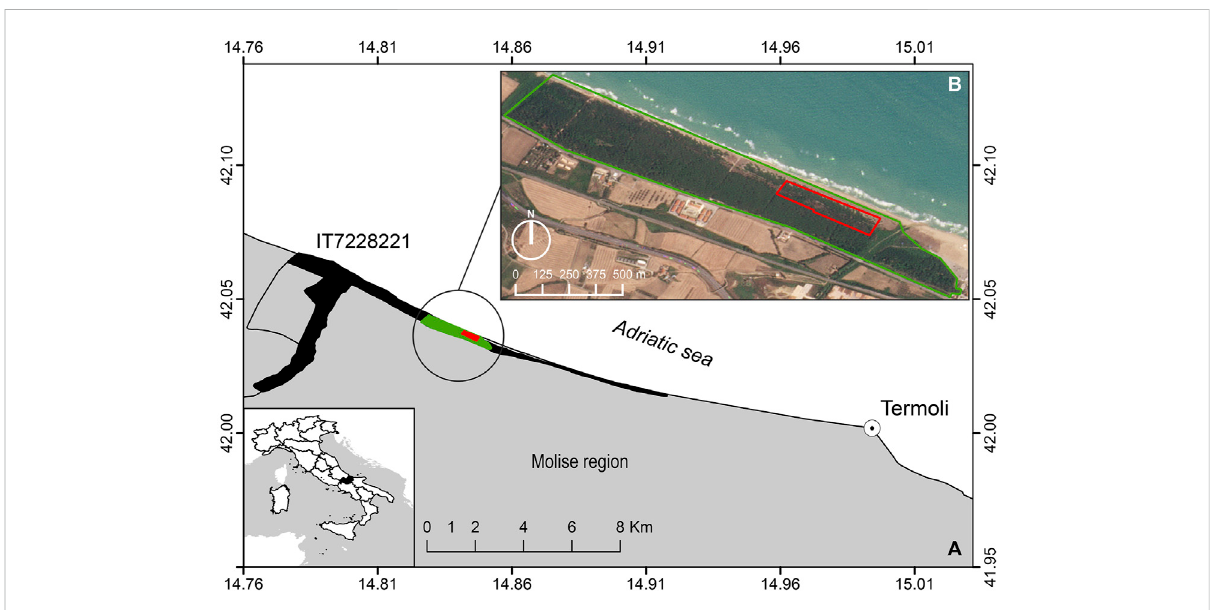
FIGURE 1 (A) Study area reporting the UAV fl ight calibration area in red and the prediction area in green (coordinate system in WGS 84 epsg: 4326). SAC and LTER site shape is reported in black (Foce Trigno – Marina di Petacciato — IT7228221,